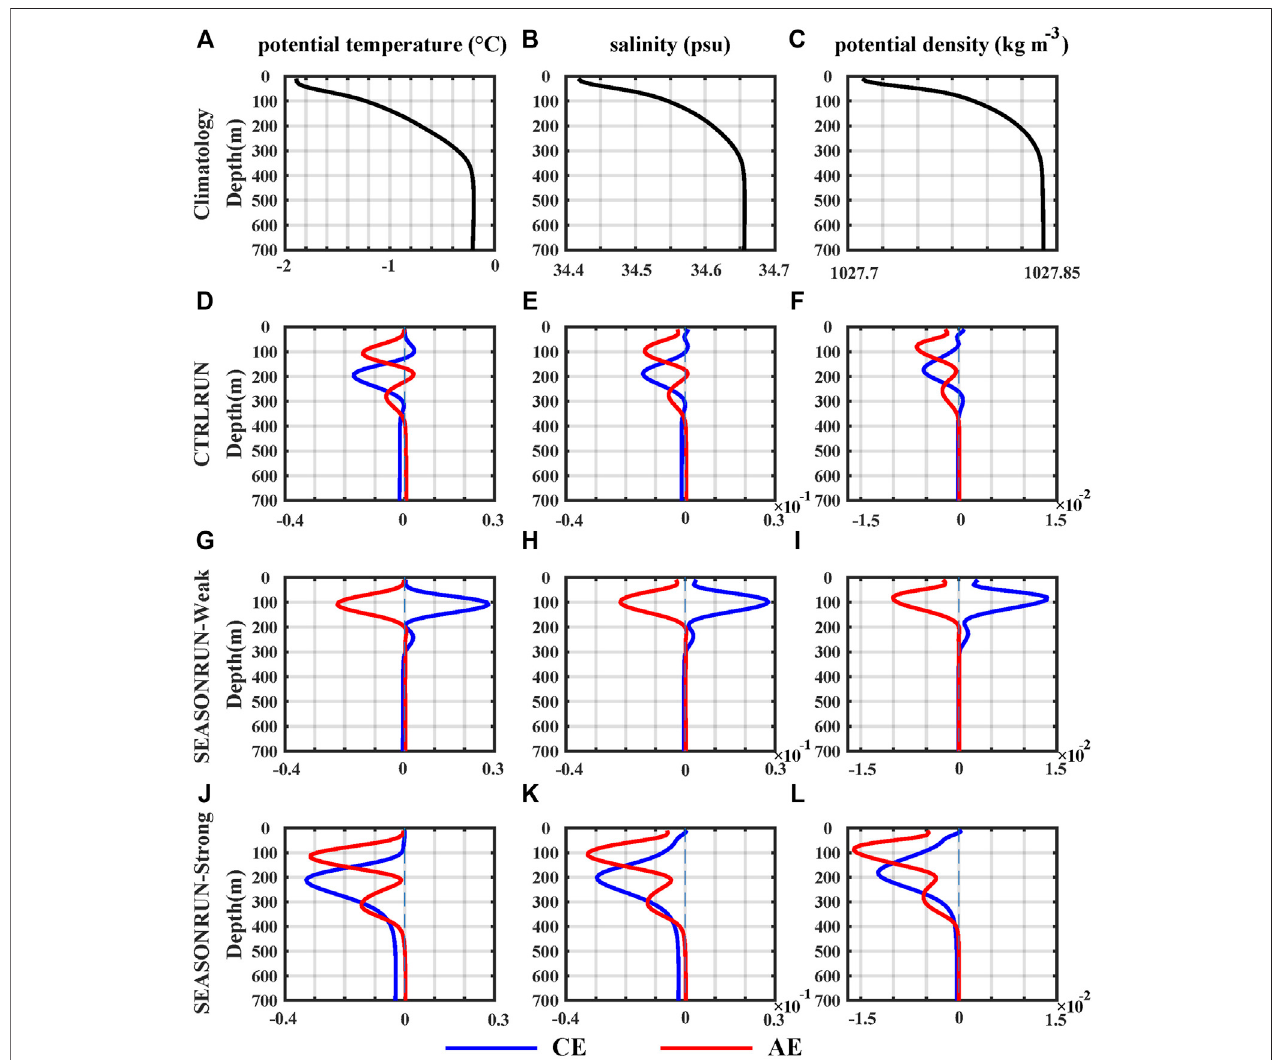
FIGURE6| (A – C) Vertical pro fi les ofthetemporal averaged potentialtemperature ( ° C), salinity (× 10 − 1 psu), and potential density (× 10 − 2 kg m − 3 ) inthe CTRLRUN overthelowercontinentalslope.Verticalpro fi lesoftheanomalieswithinthecompositeeddiesintheCTRLRUN,forthepotentialtemperature (D) ,thesalinity (E) ,andthe potential density (F) . (G – I) Same as (D – F) , but for the composite eddies in the SEASONRUN-Weak. (J – L) Same as (D – F) , but for the composite eddies in the SEASONRUN-Strong. Blue lines are the anomalies of the composite eddies of the CE, and red lines are the anomalies of the composite eddies of the AE.